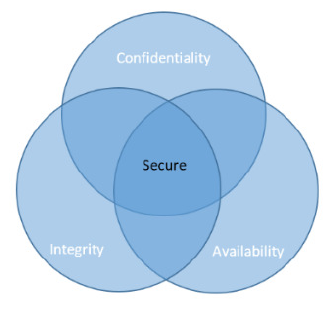
Figure 1. Security CIA